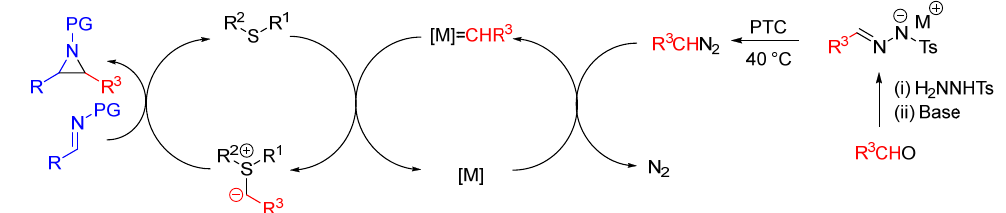
Scheme 25. Connon’s enantioselective synthesis of terminal aziridines.